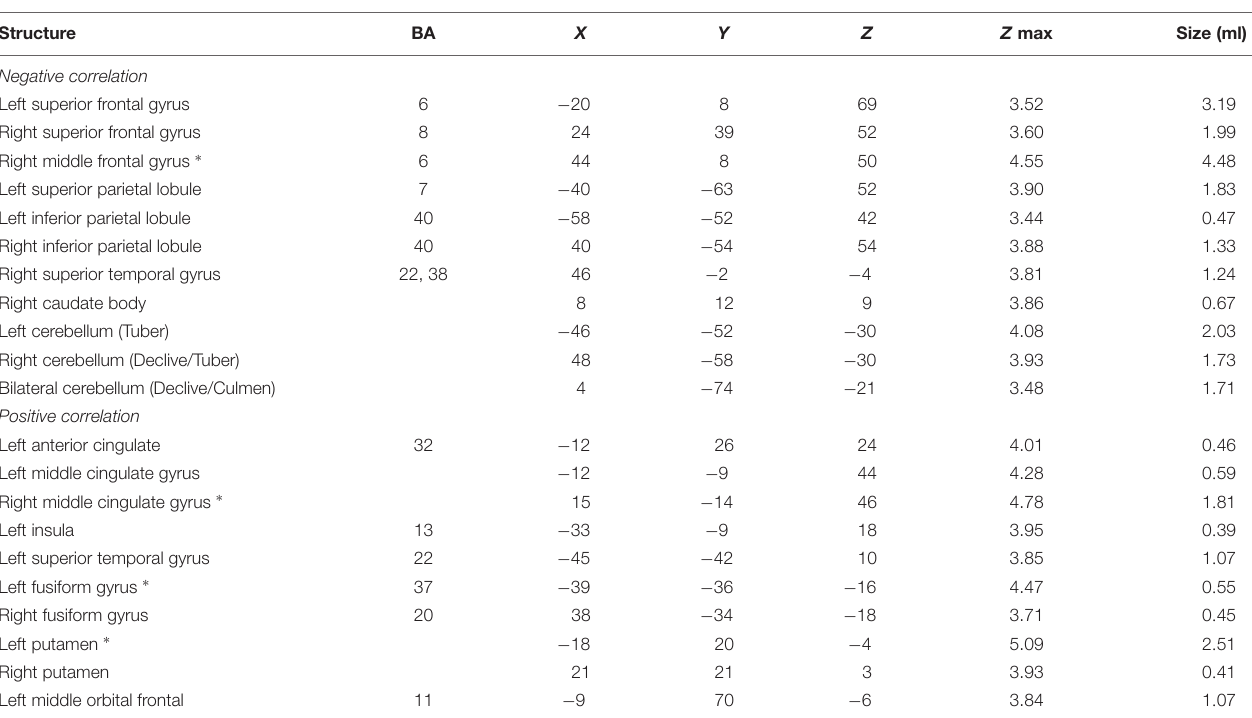
TABLE 3 | Regions with age-related relative changes in globally adjusted CBF.